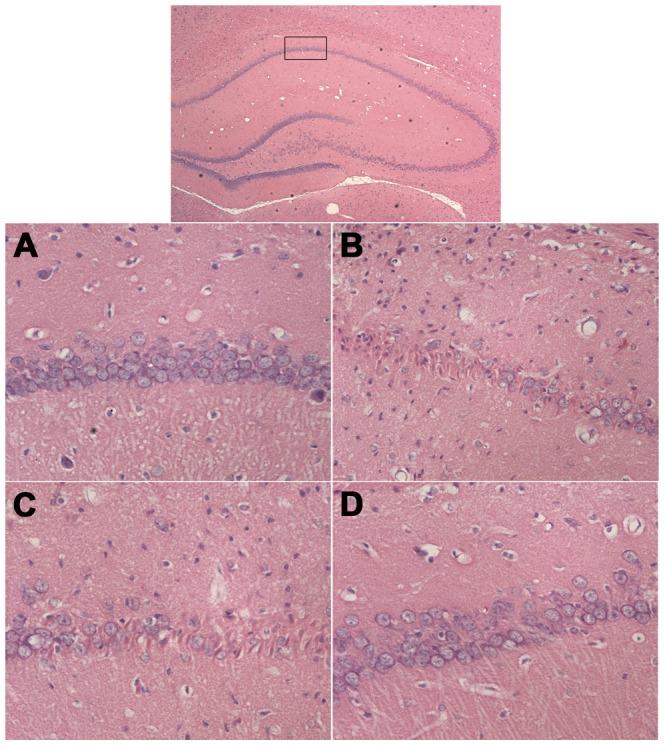
HE staining (×400).
A, control group; B, untreated group; C, Rg1+GW9662 group; D, Rg1 group. Control group, intrahippocampal injection of normal saline and intraperitoneal injection of normal saline; Untreated group, intrahippocampal injection of Aβ1–42 and intraperitoneal injection of normal saline; Rg1+GW9662 group, intrahippocampal injection of Aβ1–42 and intraperitoneal injection of Rg1 and GW9662; Rg1 group, intrahippocampal injection of Aβ1–42 and intraperitoneal injection of Rg1. Rats in the control group did not show histopathological abnormalities. In the untreated and Rg1+GW9662 groups, the number of cells in the hippocampal CA1 region appeared decreased. Furthermore, the remnants of the pyramidal cells were arranged irregularly and some exhibited shrunken and irregular shape. The cells in the Rg1 group had better cell morphology and were more numerous than those in the untreated and Rg1+GW9662 groups.